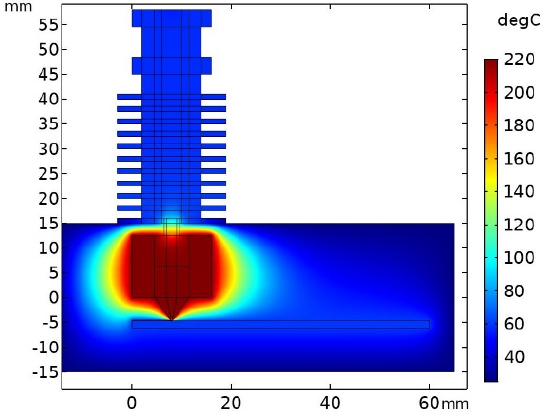
Figure 4. Static model output—temperature distribution in the examined area.